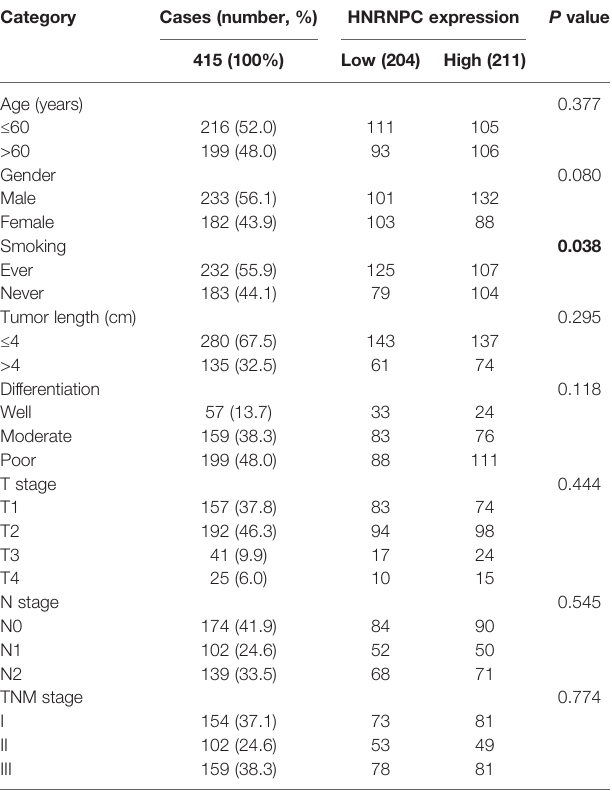
TABLE 3 | Correlations between heterogeneous nuclear ribonucleoprotein C (HNRNPC) expression and clinicopathological parameters of 415 patients with lung adenocarcinoma (LUAD) in National Cancer Center of China (NCC)